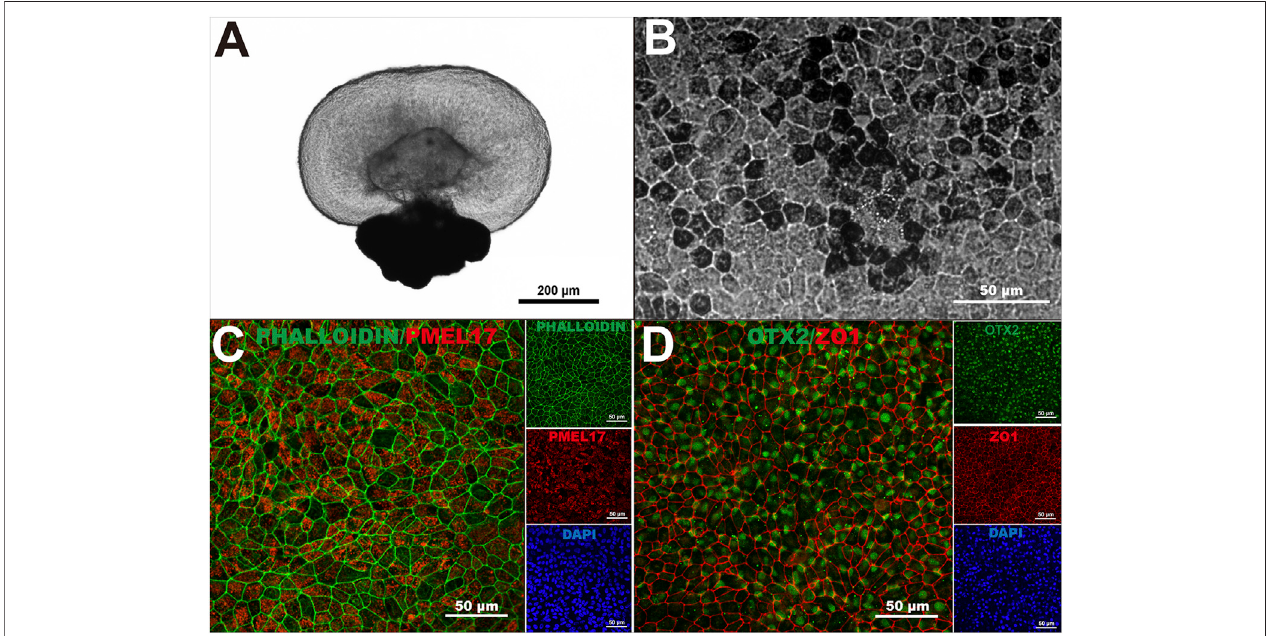
FIGURE1| Generationofhuman-inducedpluripotentstemcell-derivedretinalpigmentepithelium. (A) Athree-dimensionalretinalorganoidcontainingneuralretina and retinal pigment epithelium (RPE) cells representative of the ones used in this study. (B) hiPSC-derived RPE showed characteristic pigmentation and typical cobblestone morphology upon 40 days in culture. (C) Intact F-actin cytoskeleton (Phalloidin) and proper localization of premelanosome protein (PMEL17) in hiPSC- derived RPE monolayers at 40 days. (D) Orthodenticle homeobox 2 (OTX2), and zonula occludens-1 (ZO-1) also showed proper pattern of expression in hiPSC- derived RPE monolayers at 40 days in culture. n >